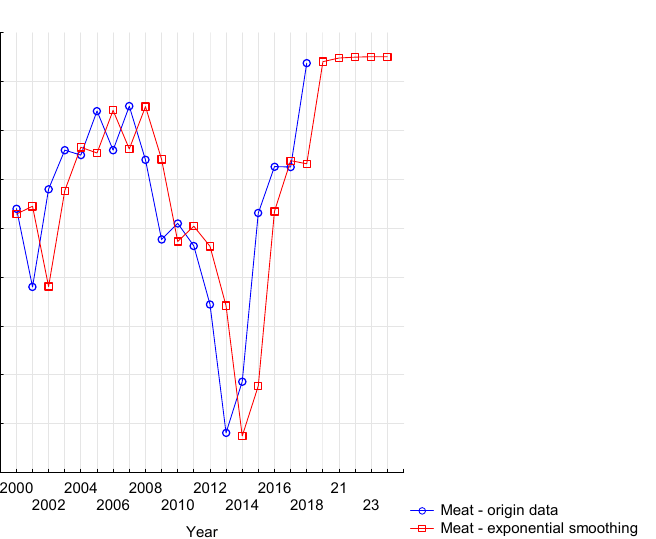
Figure 14. Prediction of total meat consumption in the Czech Republic until 2024 (kg/person/year) [27].